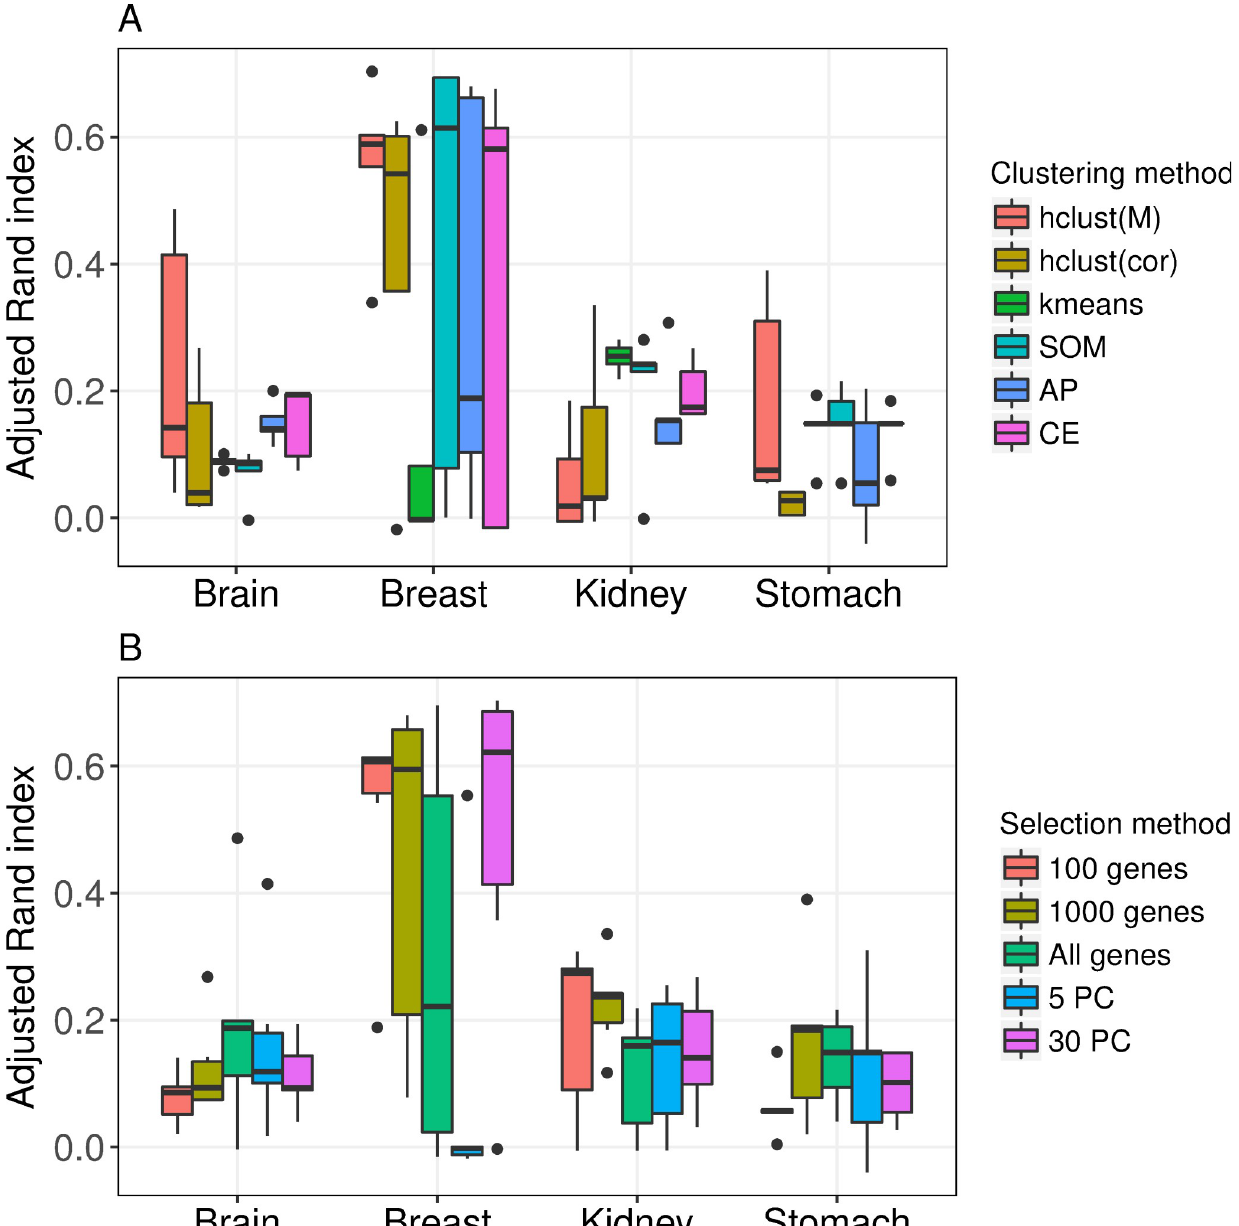
Fig 2. Performance of clustering methods and selection methods. Adjusted Rand index for clustering result compared to gold standard partition. Figure A shows results for the clustering methods, where each box contains observations from the five selection methods. Figure B shows results for the selection methods, where each box contains observations from the six clustering